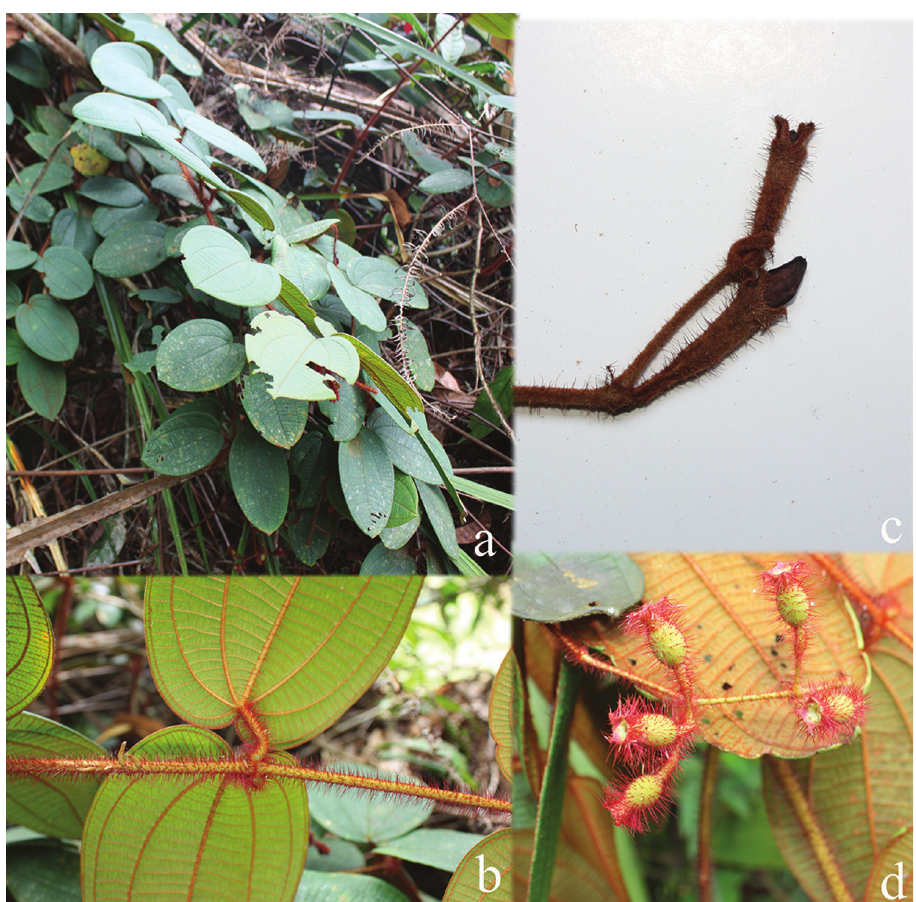
Figure 18. Dissochaeta horrida a habit b branchlet c hypanthium d fruits. Photographs by A. Karton- egoro; vouchers: Kartonegoro 1073 (BO,